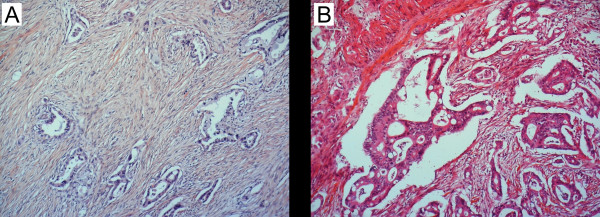
The two dominant types of histologic differentiation in periampullary adenocarcinomas: (A) The pancreatobiliary type typically has simple or branching glands and small solid nests of cells surrounded by a desmoplastic stroma, and cuboideal to low columnar epithelium arranged in a single layer without nuclear pseudostratification, the nuclei rounded but with marked variation in size and shape from one cell to the next. (B) The intestinal type typically resembles colon cancer, may consist of solid nests with cribriform areas, has tall and often pseudostratified columnar epithelium with oval nuclei located in the more basal aspects of the cytoplasm, and there may also often be presence of mucin.